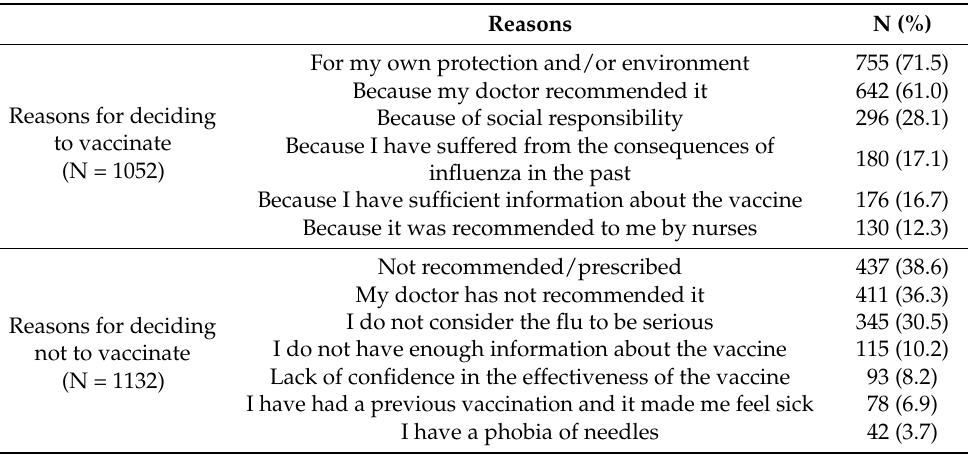
Table 3. Reasons why people chose to get vaccinated against flu or not in previous campaigns 1